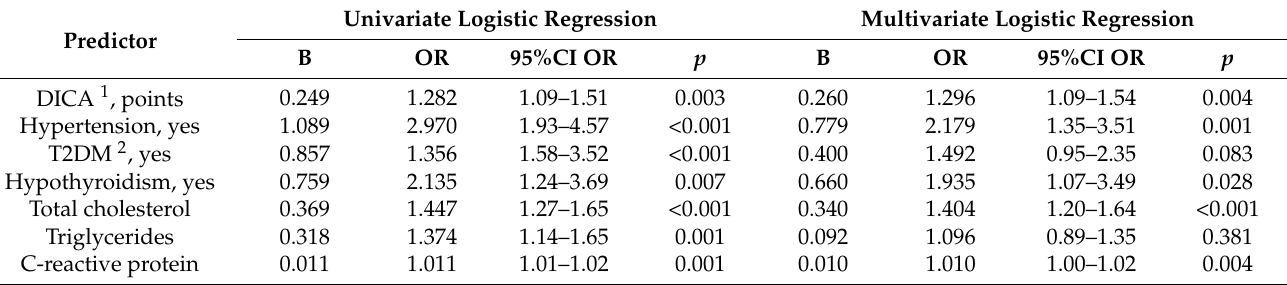
Table 4. Predictors of hepatic